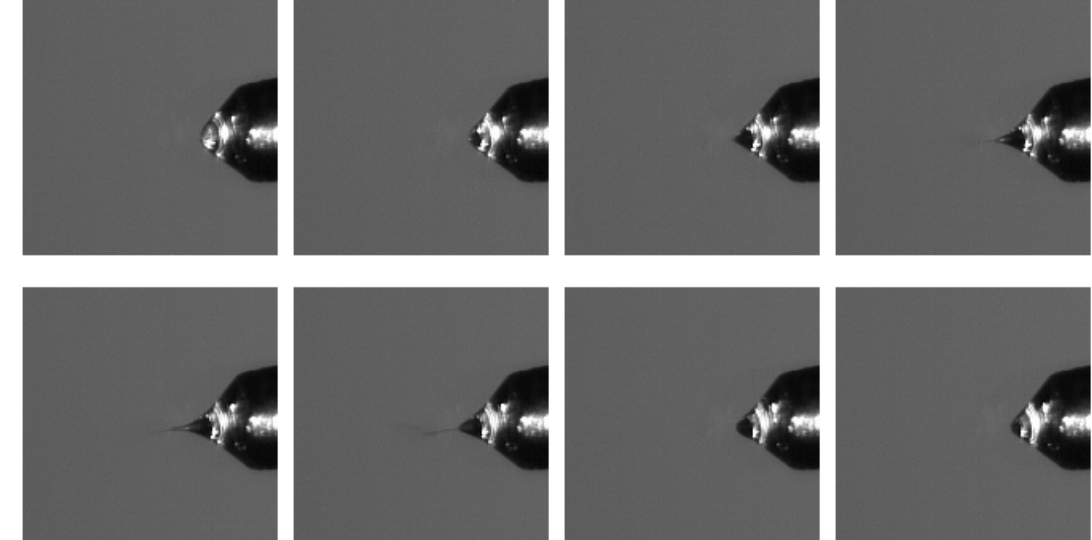
Figure 32. Formation of a splaying jet and its decay. Photographs are taken 0.1 ms apart. The experiment was done in setup II with solution a0 at 22.0 ◦ C and relative humidity 40%. Photographs were exported from the record of the Olympus i-SPEED 720 high-speed camera using i-SPEED Software Suite